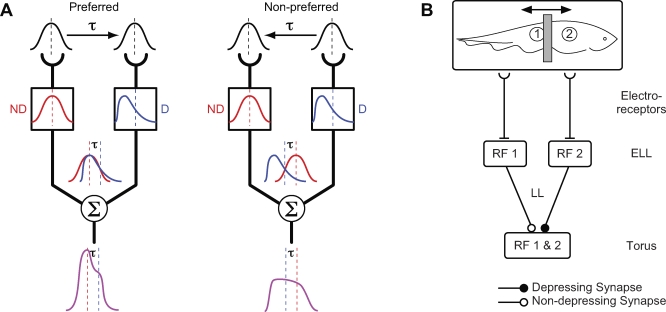
Short-Term Synaptic Depression Can Contribute to Direction Selectivity in an Elementary Reichardt Detector(A) Information from two channels (blue and red: right and left, respectively) converges on a post-synaptic cell. The blue channel exhibits short-term synaptic depression (D), which nonlinearly filters the stimulus, advancing the timing of the channel's peak response relative to the timing of the peak of the stimulus (blue dashed lines). The red channel exhibits no depression (ND), which linearly scales the stimulus, leaving the timing of the channel's peak response to coincide with the timing of the stimulus (red dashed lines). Differences in temporal processing interact with a spatial separation of the two channels' receptive fields to produce direction selectivity. A moving stimulus pulse first activating the red channel leads to the summation of coincident peaks in the post-synaptic cell. A stimulus pulse moving in the opposite direction leads to the summation of disparate peaks and hence a weaker response in the post-synaptic cell.(B) A schematic outline depicting the ascending electrosensory system in Apteronotus and Eigenmannia and other Gymnotiform genera. In short, electrosensory information from receptors in the skin (RF 1 and RF 2) project topographically onto the electrosensory lateral line lobe (ELL). Neurons in the ELL in turn project topographically onto neurons in the torus semicircularis (Torus) in the midbrain via the lateral lemniscus (LL). Midbrain afferents include both depressing and nondepressing synapses that converge on to individual neurons: this convergence of information meets the requirements for the proposed elementary Reichardt motion detector. We used three categories of stimuli: global stimuli (social signals that stimulate the entire sensory surface simultaneously), a localized moving bar (shown), and a larger moving sinewave grating.